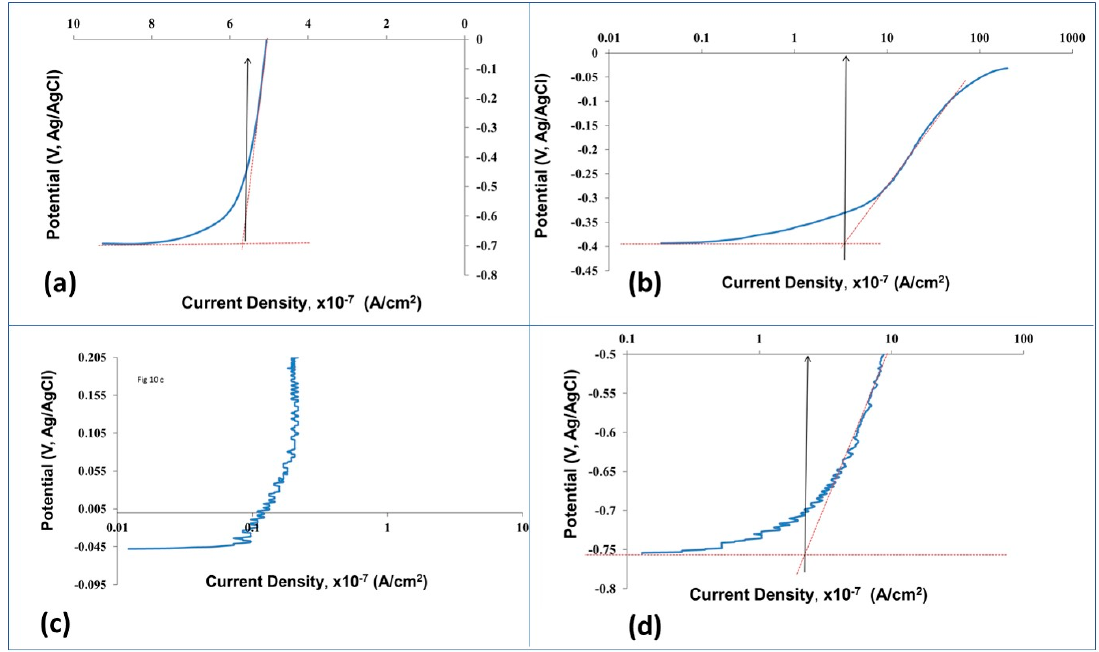
Figure 9. Comparison of breakdown potential from AP measurements for the tested materials against the Ag/AgCl reference electrode.